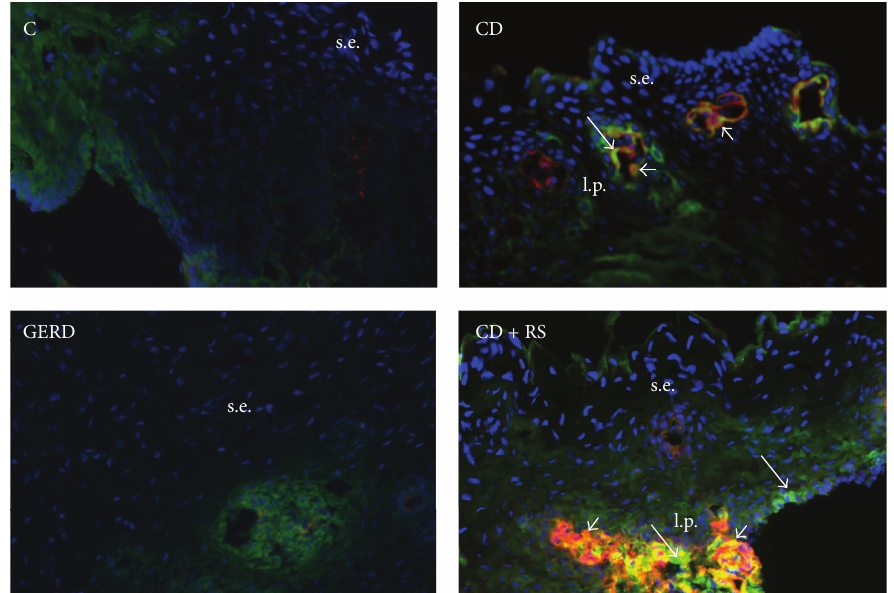
Figure 2: Example of immunofluorescent staining in the esophageal mucosa of a healthy control (C), a CD patient without RS (CD), a GERD patient, and a CD patient with reflux symptoms at the time of diagnosis (CD + RS) (magnification 20x). tTG2 (red); IgA deposits (bright green, perivascular, long arrows); IgA-TG2 deposits (orange/yellow, short arrows); s.e.: squamous epithelium; l.p. = lamina propria. Dull green background in C and GERD due to autofluorescence and nonspecific